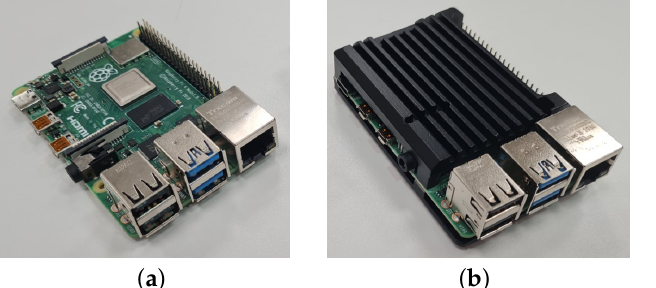
Figure 3. Raspberry Pi 4B without ( a ) and with ( b ) heat sink. ( a ) Raspberry Pi 4B without heat sink. ( b ) Raspberry Pi 4B with heat sink.